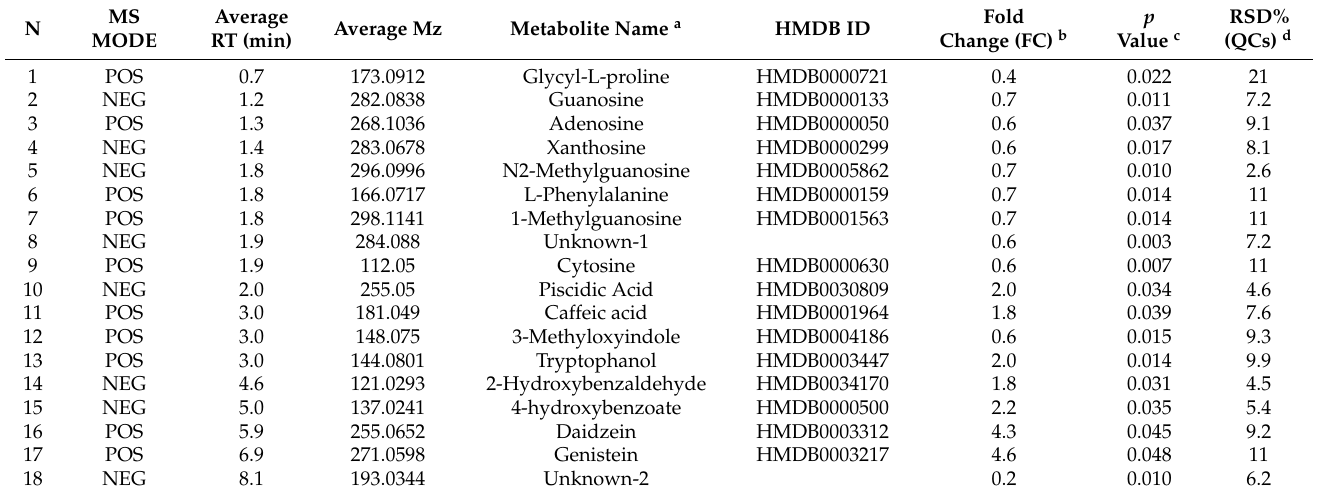
Table 1. A list of the 18 significant metabolites of inflammation in sow urine (farm A and n = 58) as identified by the RP-UHPLC-qTOF MS/MS and PLS-DA models. Metabolites were significant when VIP > 1 and p < 0.05. Biomarkers were sorted by RT (ascending).